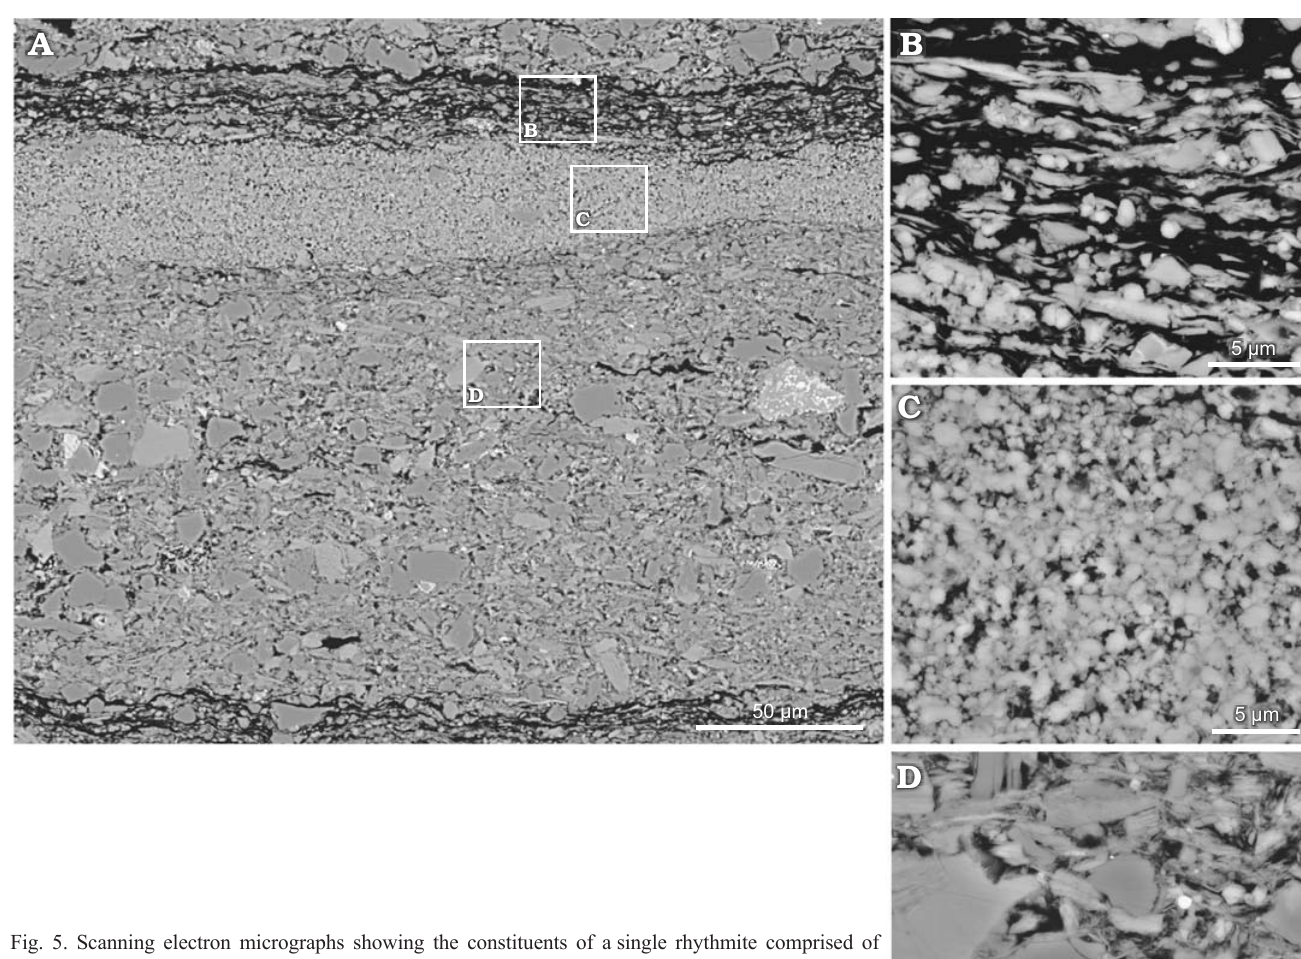
Fig. 5. Scanning electron micrographs showing the constituents of a single rhythmite comprised of three distinct layers; shale USNM 560101; Coal Creek member of the Kishenehn Formation, Eocene, Montana, USA. A . A thin-section of one rhythmite. The black mat at the bottom of the photograph is part of an underlying rhythmite (frames show the exact locations of B–D). B – D . Higher magnification photographs of the three layers of the rhythmite. B . A microbial mat consisting of black organic matter, primarily carbon, small amounts of calcite crystals and scattered larger siliciclastic particles. C . Small crystals of calcite (CaCO ). D . A thick layer consisting largely of various particles of siliciclastic 3